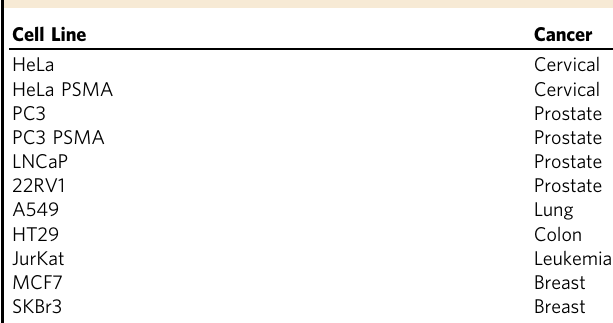
Table 2 Cell lines used in this